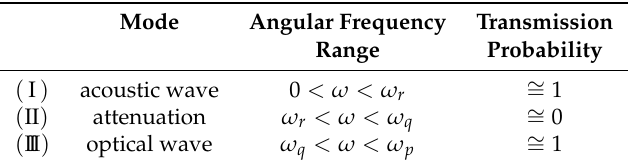
Table 2. Each vibrational mode (left), angular frequency range (center) and transmission probability (right) † . Mode Angular Frequency Transmission Range Probability ( I ) acoustic wave optical